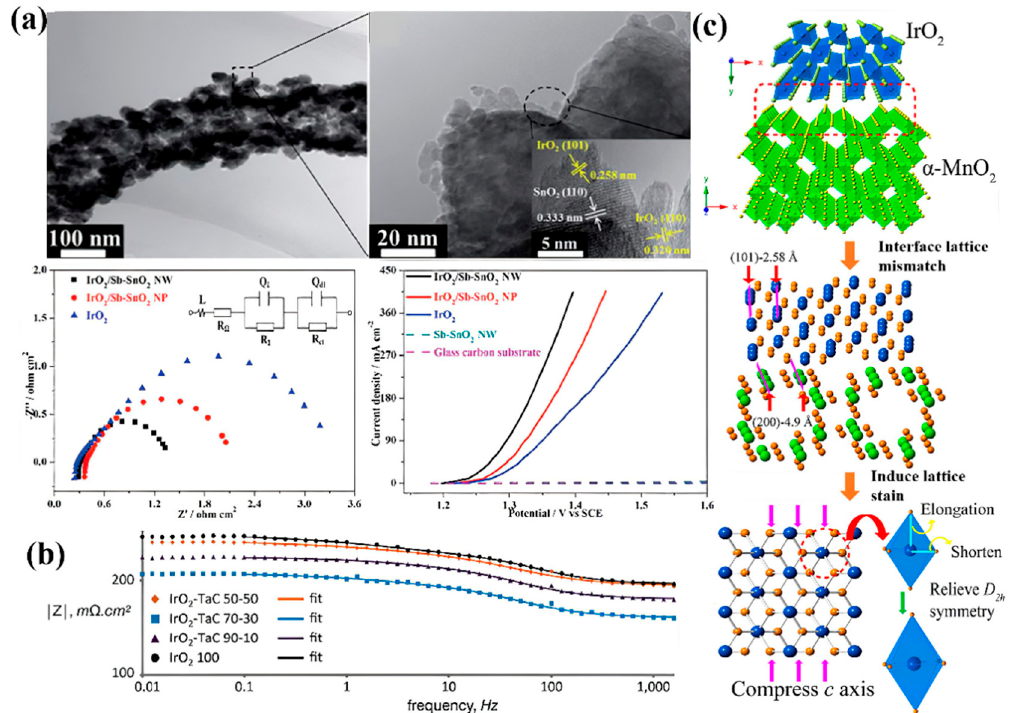
Figure 3. ( a ) Low- and high-magnification transmission electron microscope (TEM) images, a Nyquist diagram, and the steady-state polarization curve of the IrO 2 /Sb-SnO 2 catalyst [37]. ( b ) Bode plot from the electrochemical impedance spectroscopy (EIS) of TaC-supported IrO 2 [79]. ( c ) Diagram of the process by which the α -MnO 2 substrate induces the lattice strain of IrO 2 [45].